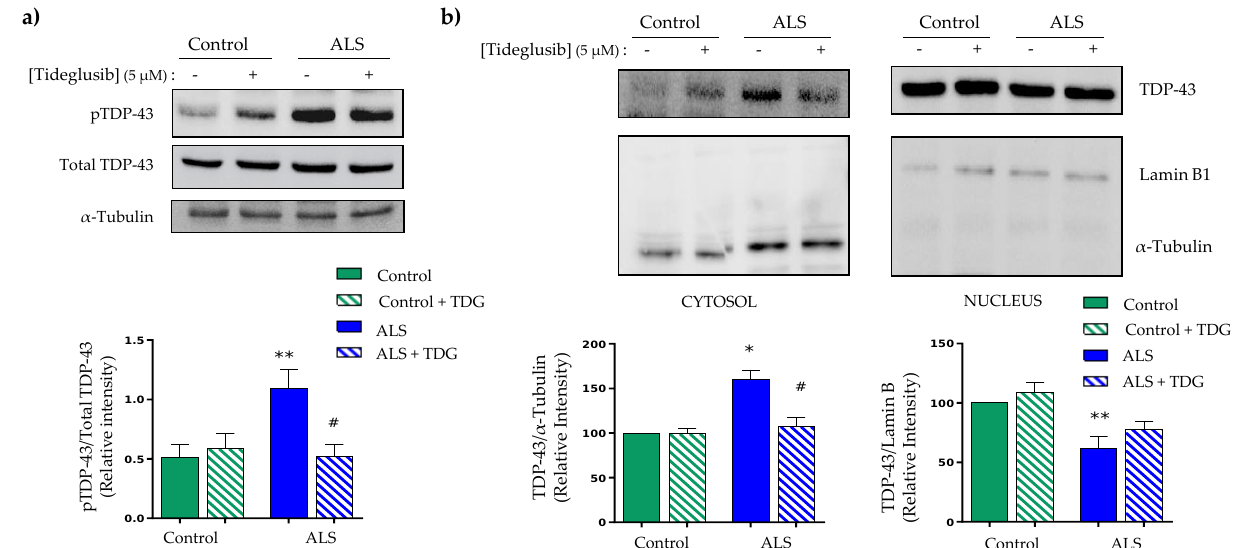
Figure 2. Effects of Tideglusib on TDP-43 phosphorylation and localization in control and ALS lymphoblasts. Immortalized lymphocytes from control and ALS individuals were seeded at an initial density of 1 × 10 6 × mL − 1 in absence or presence of Tideglusib (TDG: 5 µ M). Twenty-four hours after drug addition, cells were harvested and processed for Western blotting analysis. ( a ) Representative immunoblot showing the effect of Tideglusib decreasing the phosphorylation status of TDP-43 in ALS lymphoblasts. The plot panel below represents the quantifications of the bands of 43 KDa of pTDP-43 normalized by Total-TDP-43. ( b ) After treatment, lymphoblasts were collected and lysed to obtain the cytosolic (left panel) and nuclear (right panel) fractions that were analyzed by Western blotting. α -Tubulin and Lamin B1 antibodies were used as loading and purity control of the cytosolic and nuclear fractions, respectively. A representative experiment is shown. Densitometric analyses represent the mean ± SEM of different observations carried out in five cell lines from each group (* p < 0.05, ** p < 0.01 significantly different from control cells; # p < 0.05 significantly different from ALS untreated cells).